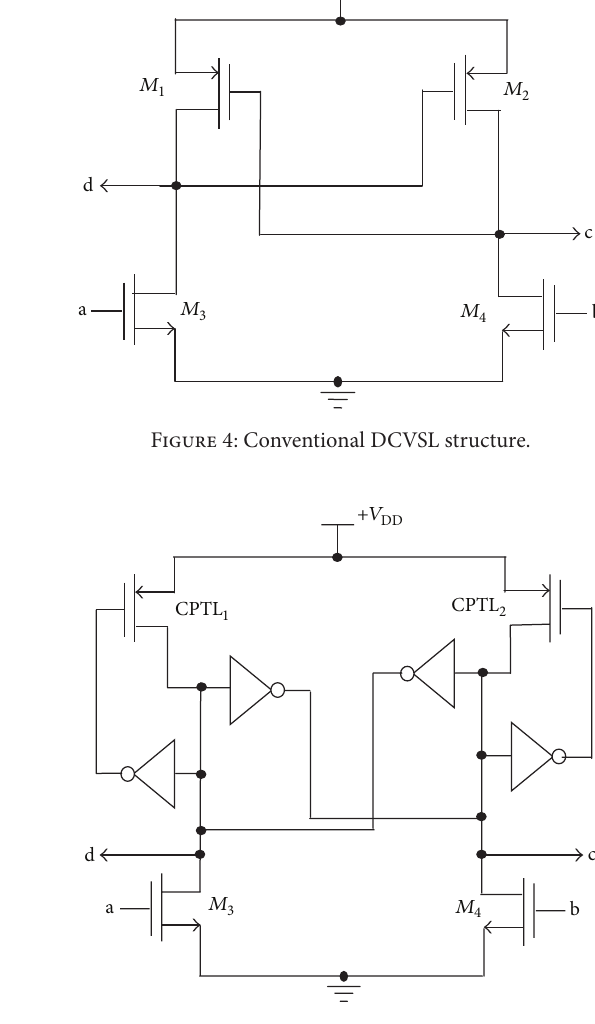
Figure 5: Proposed DCVSL